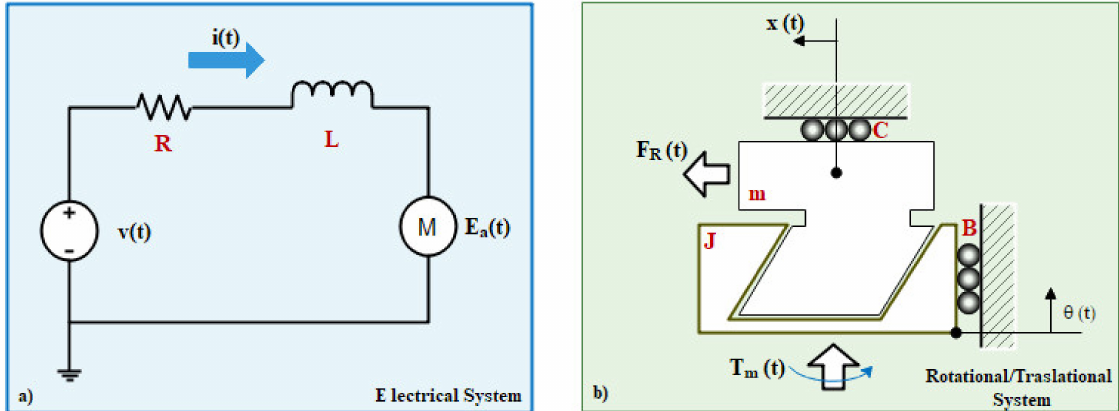
Figure 6. Wheelchair mechanism parts: ( a ) Idealized physical model of the DC linear motor ( b ) Screw mechanism with an interface of rotational to linear